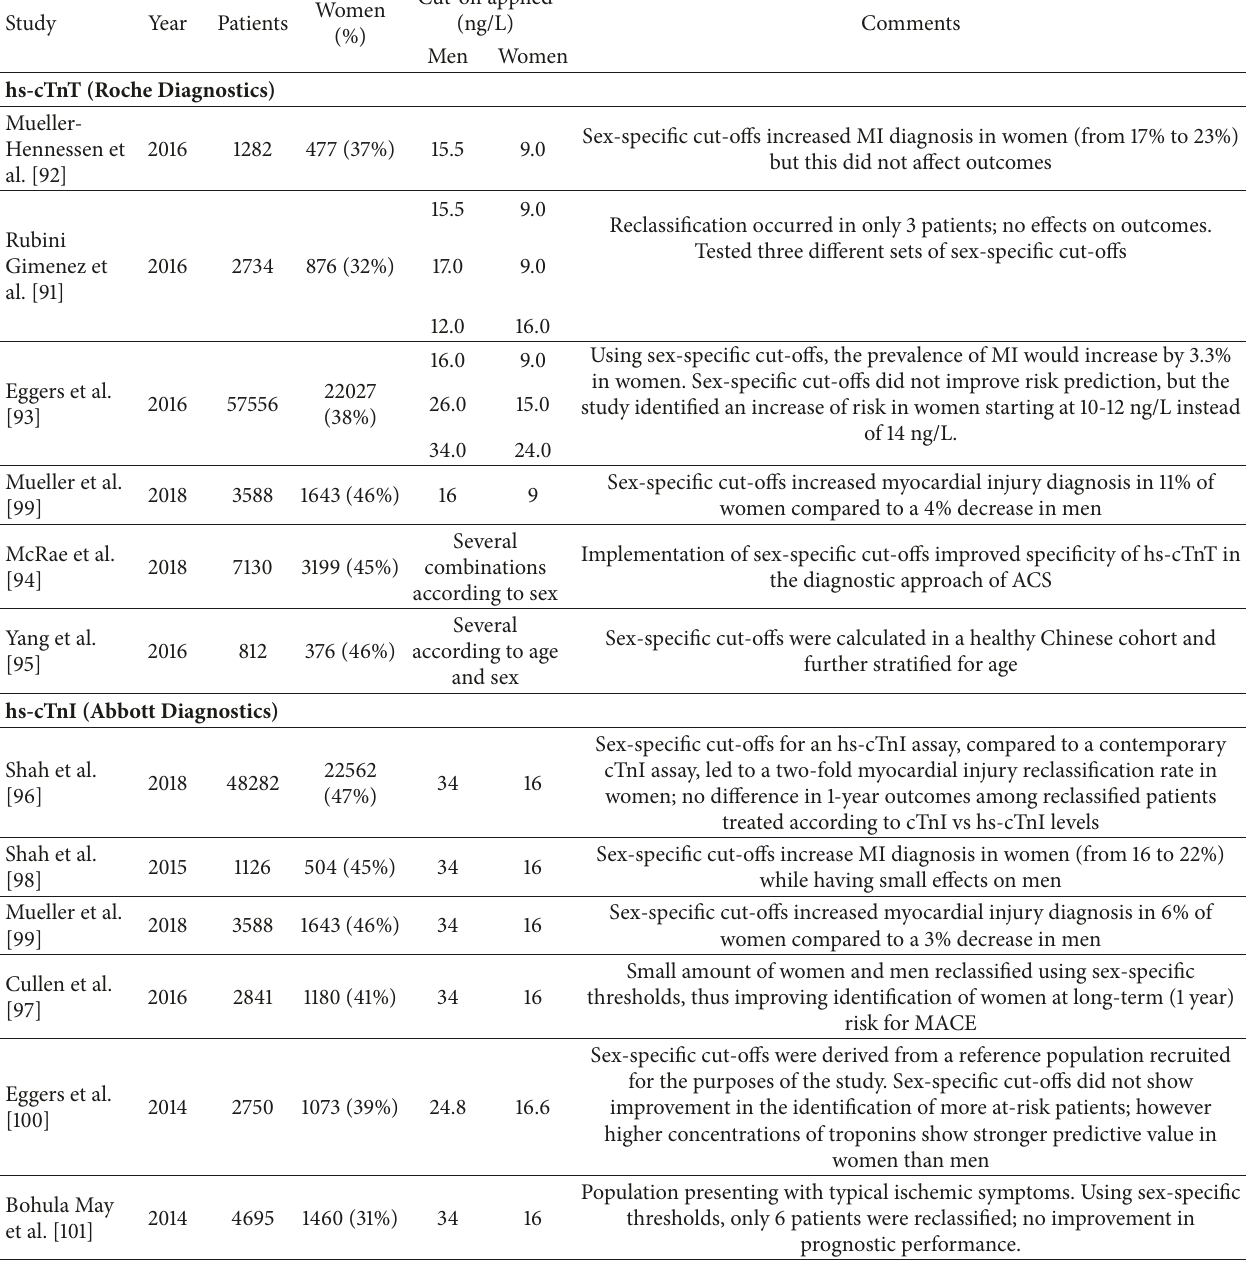
Table 3: Studies reporting performance and prognostic impact of sex-specific cut-offs in different populations. MACE: major adverse cardiovascular events; MI: myocardial infarction.